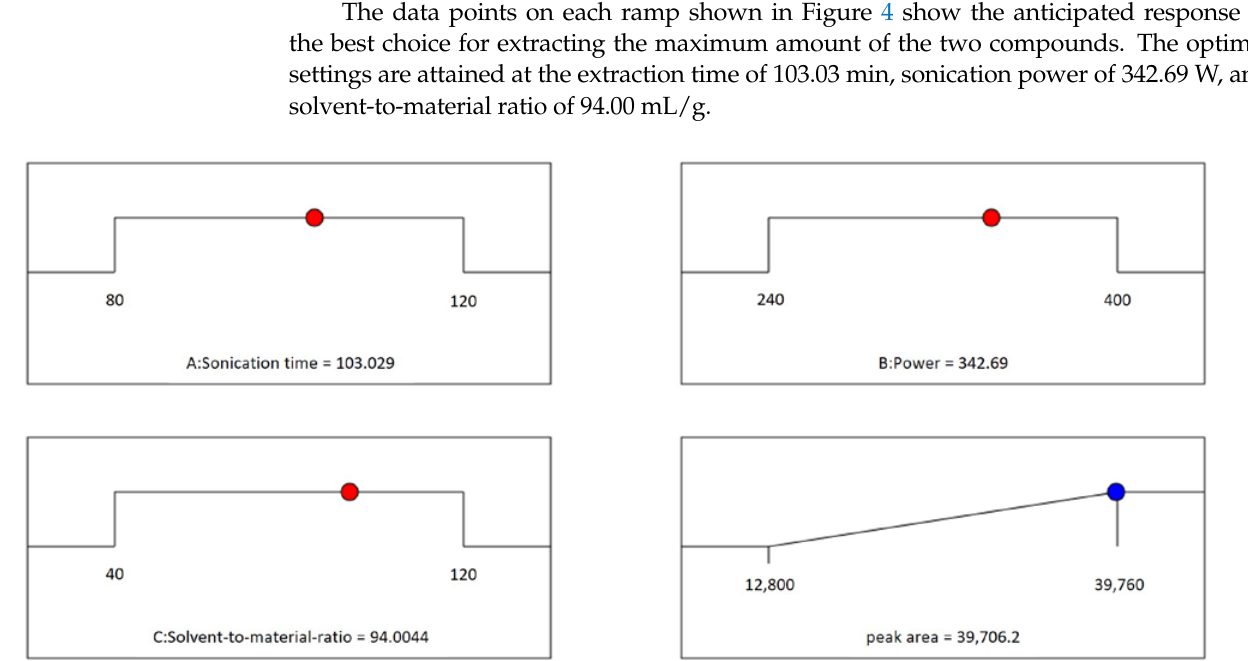
Figure 4. Desirability ramps for the three variables to obtain the maximum total amount of two compounds (desirability = 0.998, solution 1 out of 1).